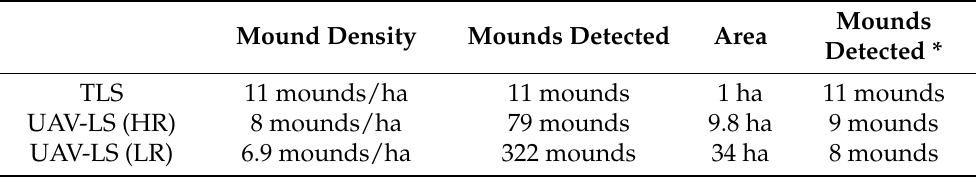
Table 3. Detected termite mounds per hectare ( > 50 cm) using our detection algorithm for the UAV-LS data sets. * mounds detected in the benchmarking